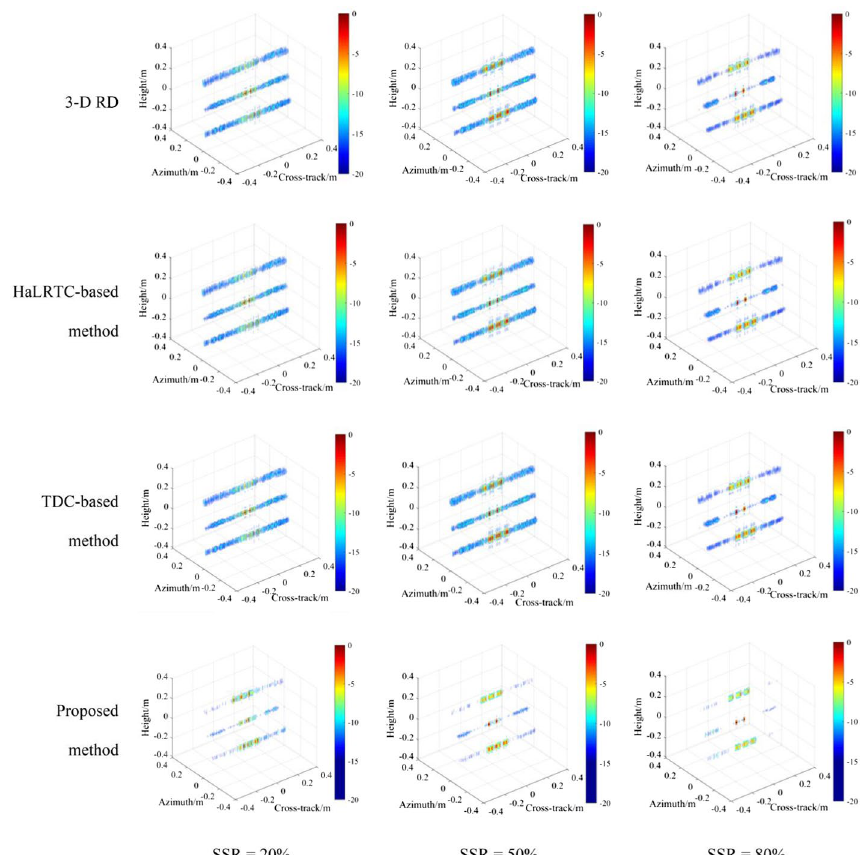
Fig. 11 Comparison of 3D imaging results by sparse data completed with various methods